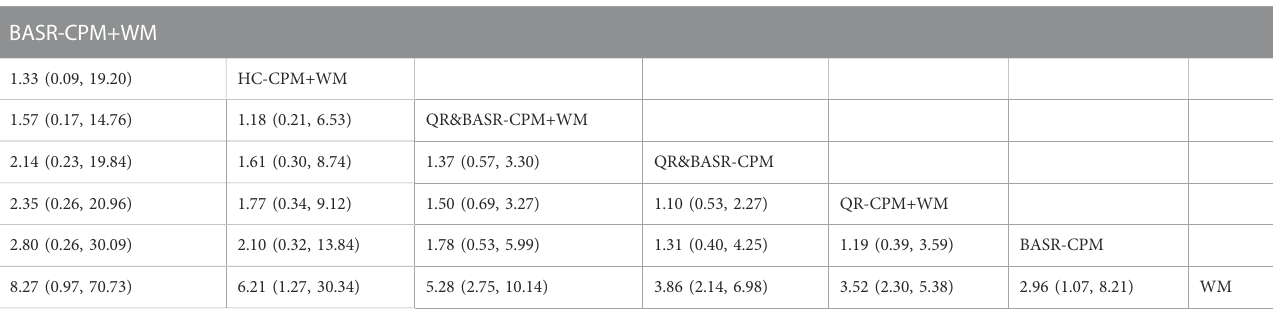
TABLE 4 Results of network meta-analysis for clinical ef fi cacy.